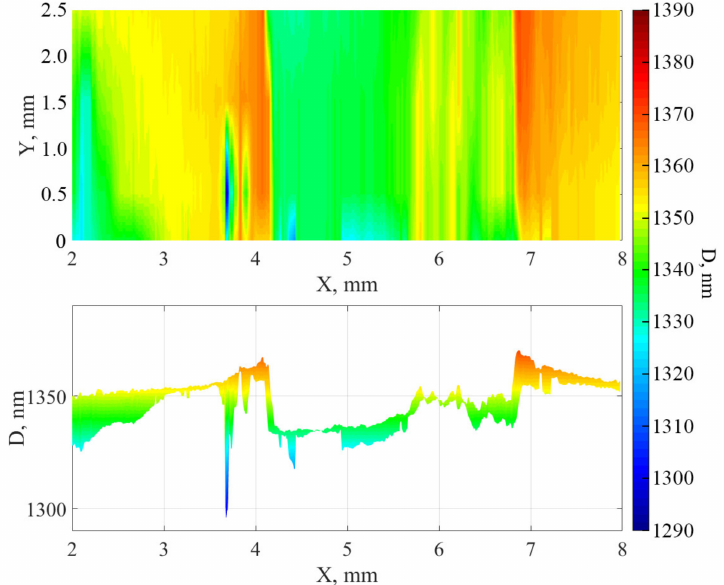
Figure 8. Principal map of the distribution of thicknesses of the aluminum nitride film on Si. Top view ( top ) and cross-section of the film ( bottom